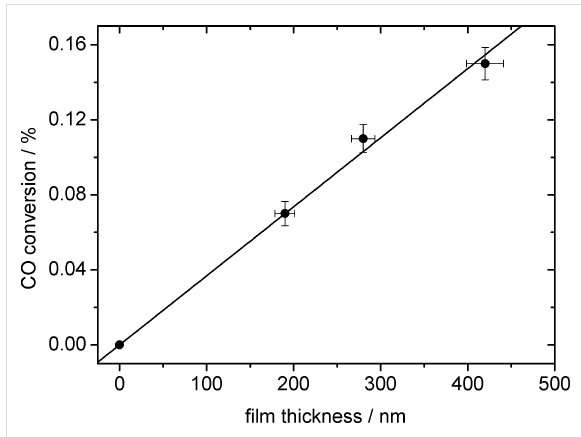
Figure 8: CO conversion measured above mesoporous Au/TiO 2 films of different thicknesses.